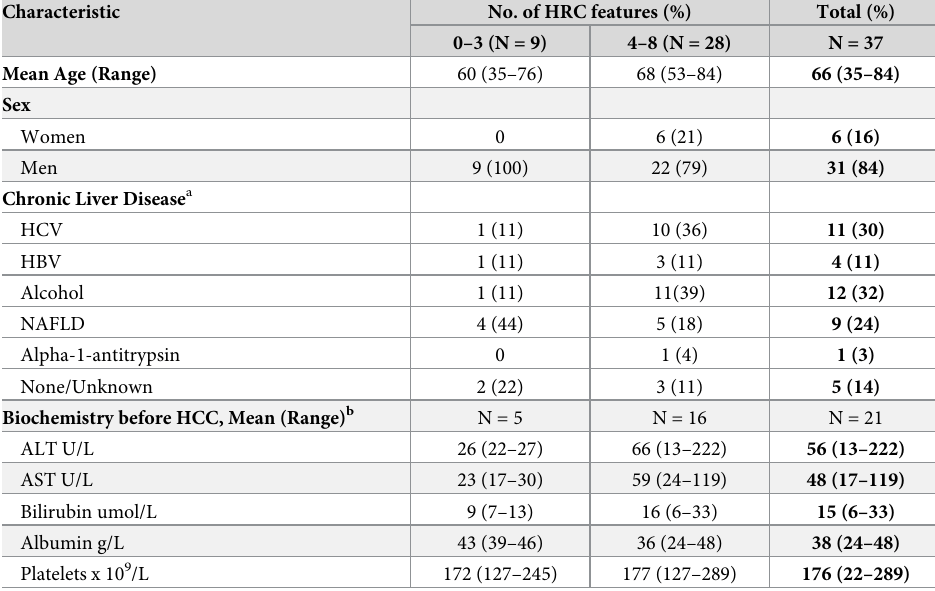
Table 1. Patient demographics and number of HRC